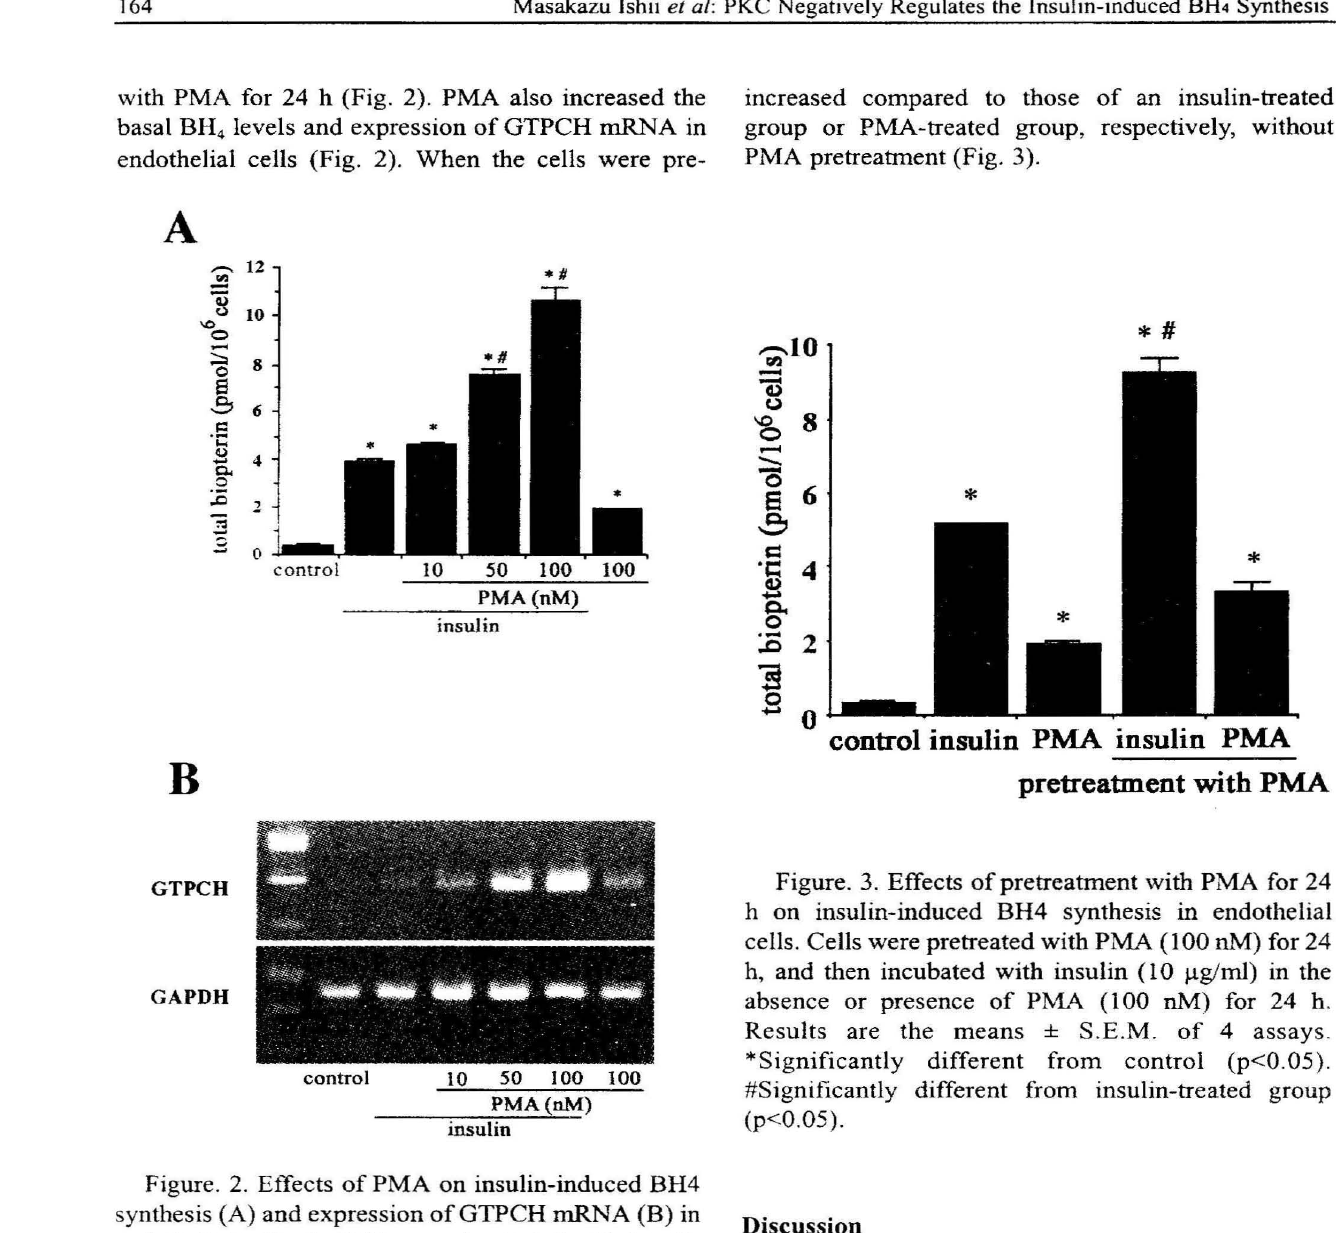
Figure. 2. EtTects of PMA on insulin-induced BH4 synthesis (A) and expression ofGTPCH mRNA (B) in endothelial cells. A : Cells were incubated with insulin ( J 0 Ilg/ml) in the presence or absence of PMA (10-100 nM) for 24 h. Results are the means ± S.E.M. of 8 assays. *Significantly different from control (p<0.05). #Significantly different from insulin-treated group (p<0.05). B: Cells were incubated with insulin (10 /lg/ml) in the presence or absence of PMA (10-100